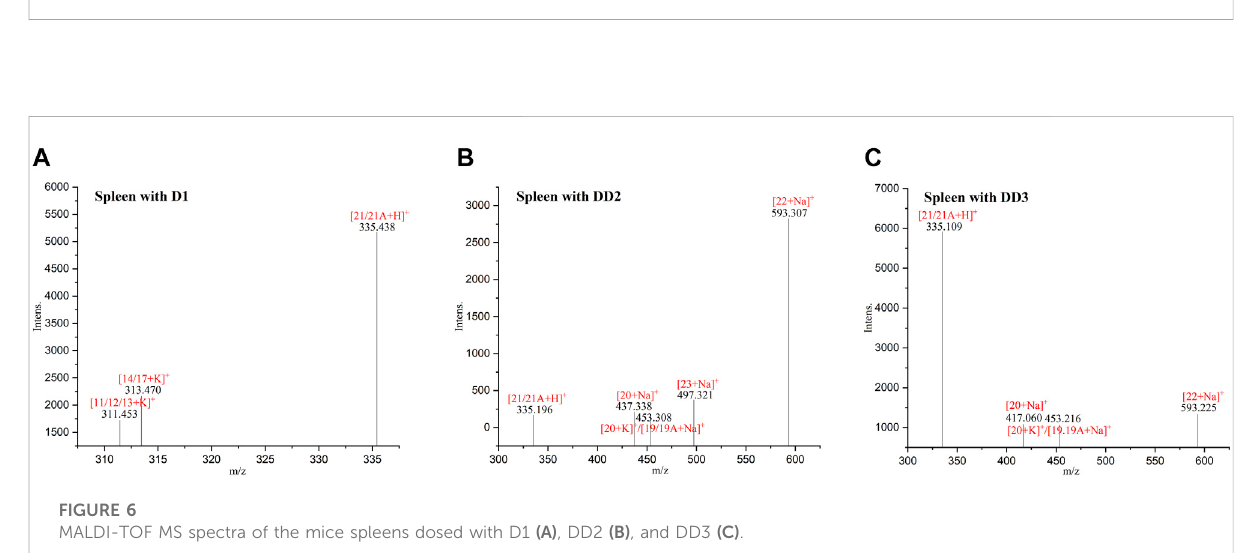
FIGURE 6 MALDI-TOF MS spectra of the mice spleens dosed with D1 (A) , DD2 (B) , and DD3 (C) .